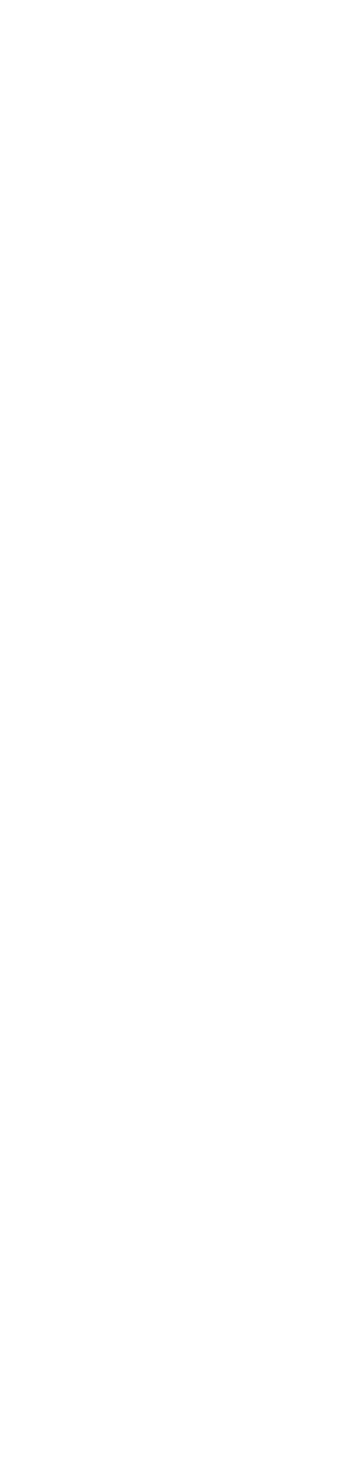
FIGURE 2 Correlation Plots of Immune Biomarkers Studied in (A) Primary, (B) Recurrent, and (C) Metastatic UPS. Correlation plots displaying only the statistically signi fi cant correlations between tumor-associated immune cells, immune checkpoints and adenosine pathway biomarkers in (A) primary, (B) recurrent, and (C) metastatic samples. The colors of the circles are representative of the Spearman correlation with the scale represented at the bottom of the plots. The size of the circles indicate the signi fi cance level of the correlation, with larger circles representing lower